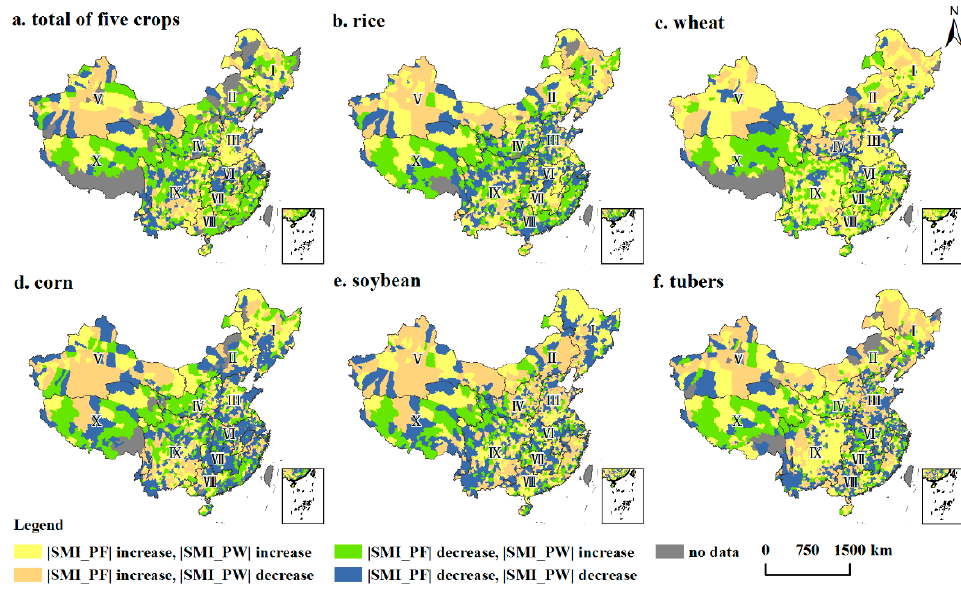
Figure 9. Changes in the degree of geographic imbalance between crop production and farmland and water resources in the period 1990–2015.